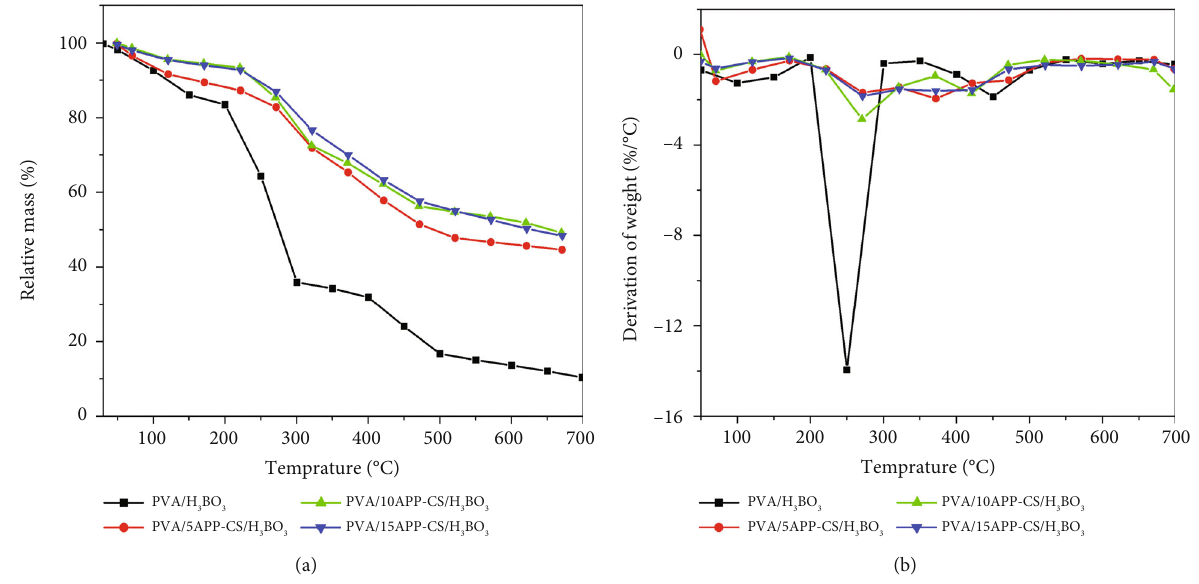
Figure 9: (a) TGA weight loss and (b) the corresponding DTG curves of the PVA composite aerogels. Table 2: TGA data of the fl ame-retardant composites obtained in N